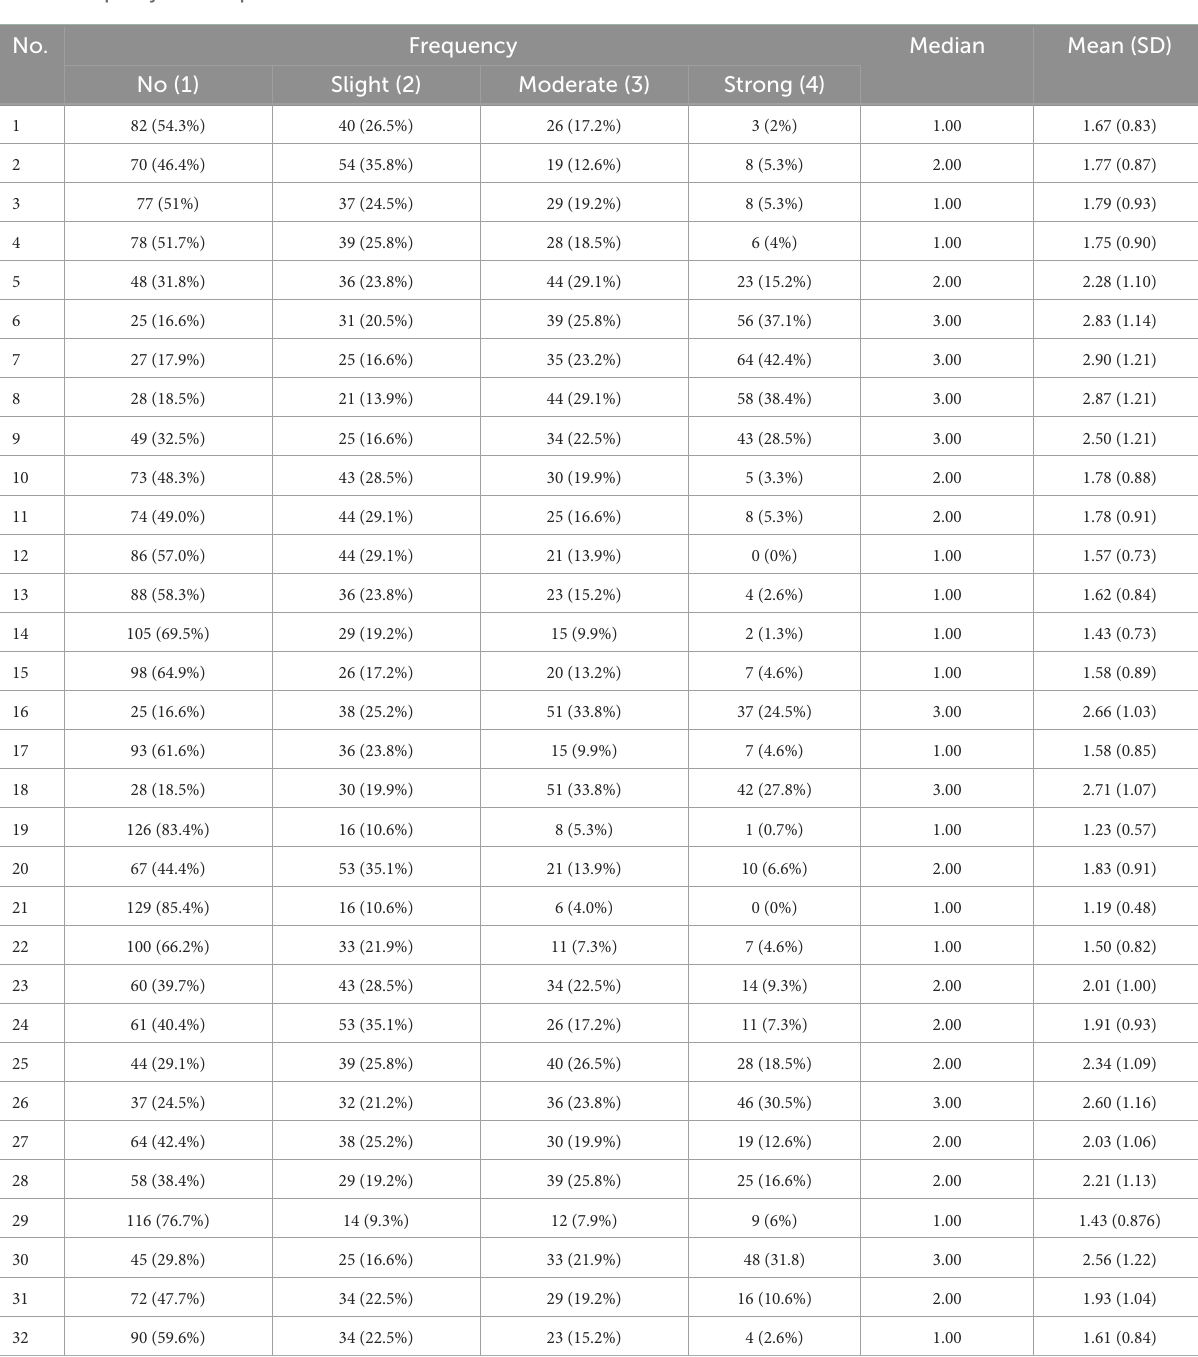
TABLE 2 Frequency of the